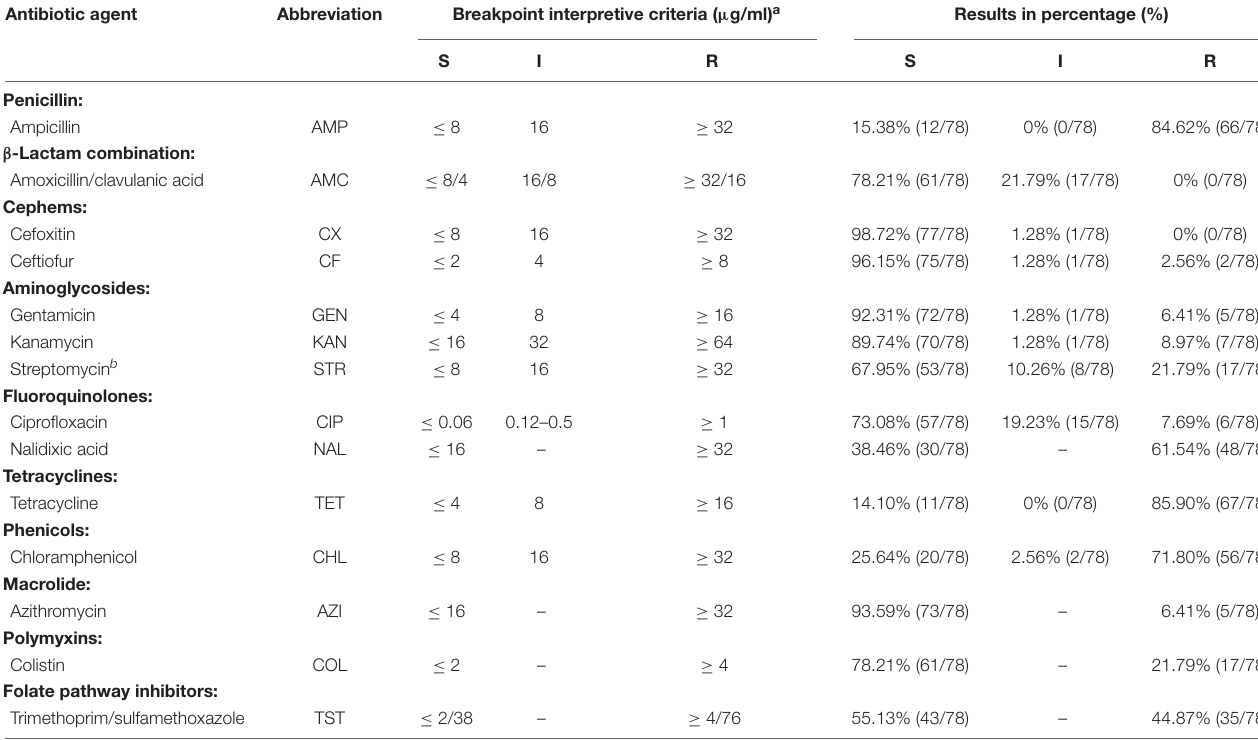
TABLE 4 | Antimicrobial susceptibility interpretation of the isolated Salmonella strains ( n = 78). Antibiotic agent